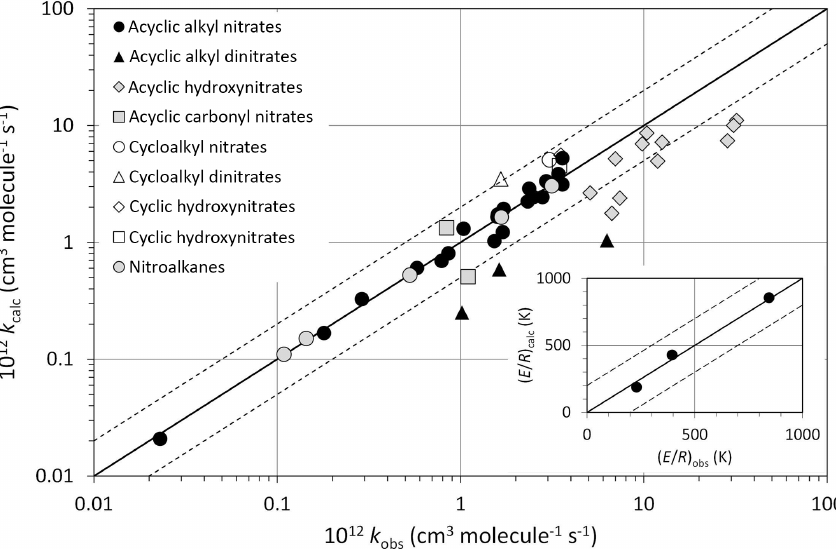
Figure 5. A log–log correlation of k calc and k obs at 298K for saturated organic nitrates and nitroalkanes. The broken lines show the factor of 2 range (see Table S1 for identities of outliers). The inset plot shows a correlation of the temperature coefficients (E/R) calc and (E/R) obs for methyl-, ethyl- and 2-propyl-nitrate. The broken lines show the ± 200K